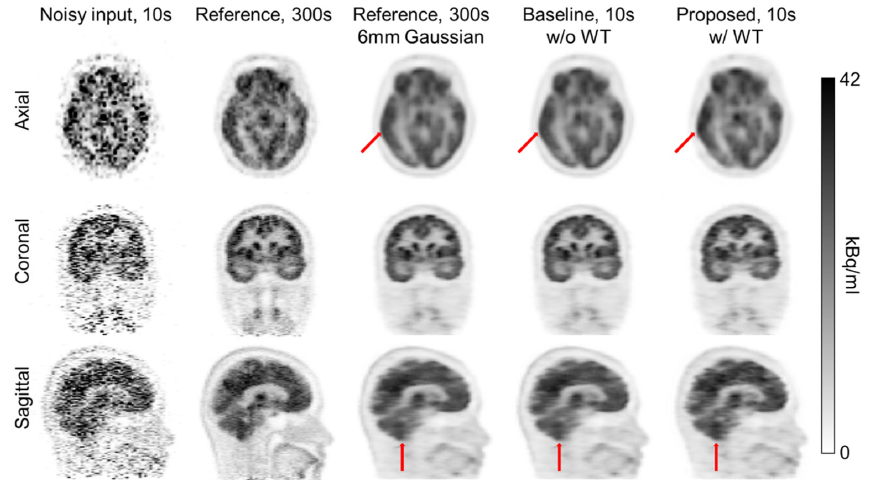
Figure 4. Full count image, noisy input, Gaussian-filtered, and denoised images using the Noise2Noise (N2N) without and with the incorporation of the trainable wavelet transform (WT) for clinical data. Red arrows indicate the region with decrease uptake in N2N without wavelet transform.